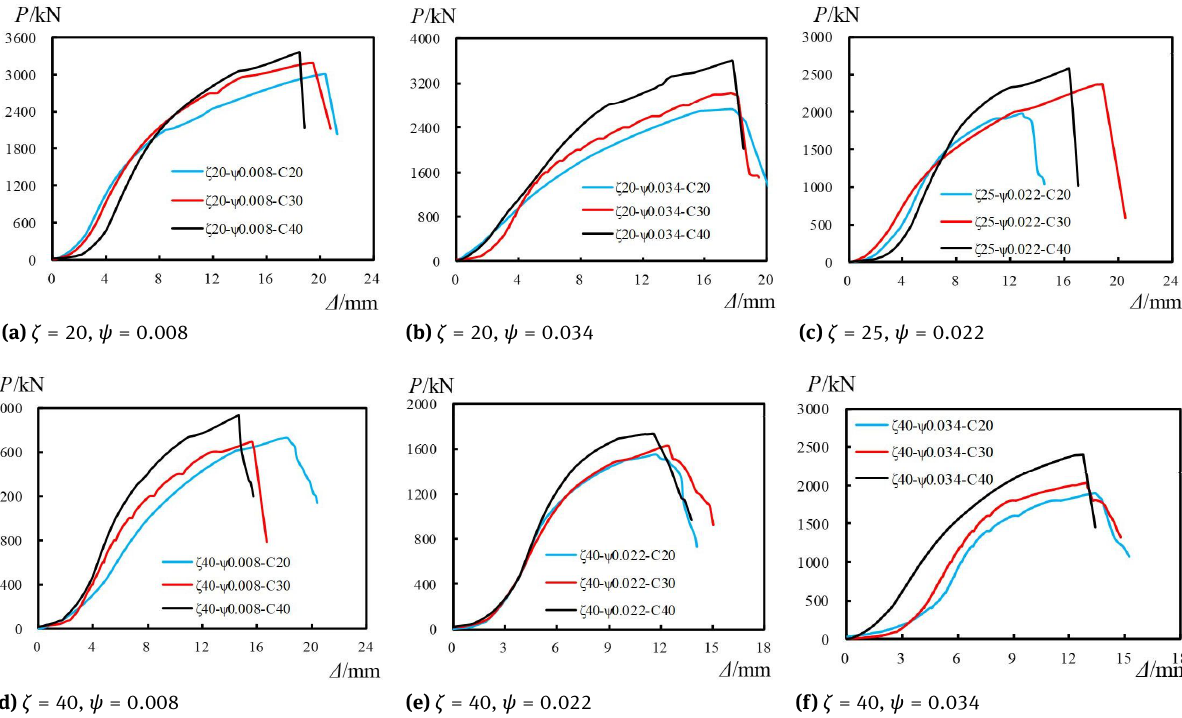
Figure 12: Typical load-displacement curves under different nano-silica concrete